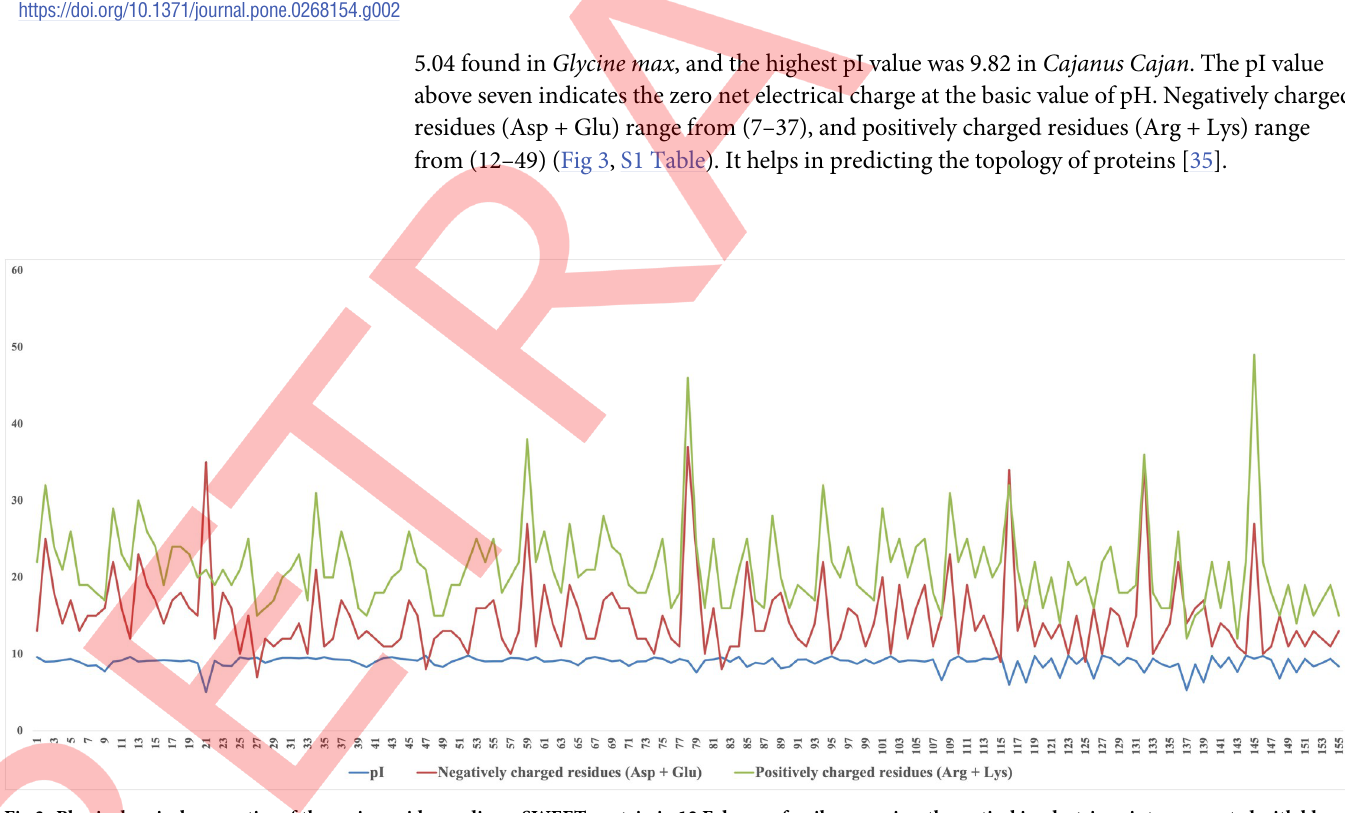
PLOS ONE | https://doi.org/10.1371/journal.pone.0268154 May 13,